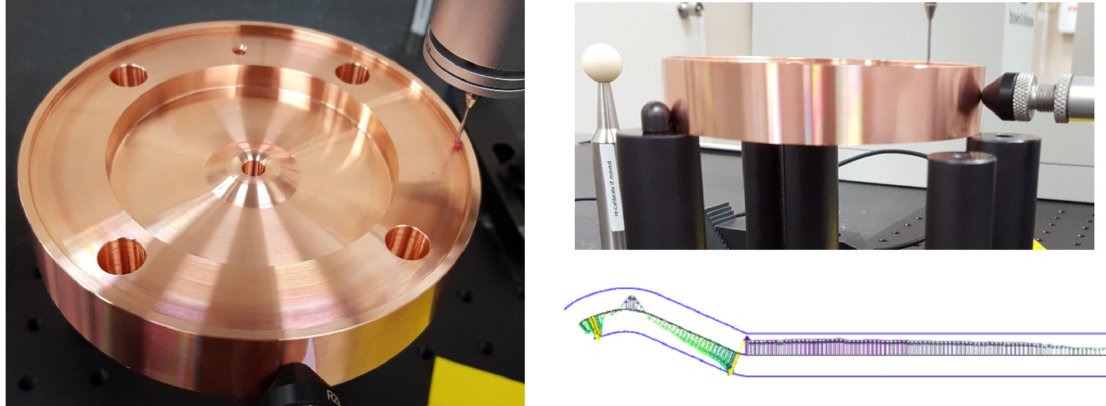
FIG. 23. Turned cell on CMM (left and top right), profile scan taken of the cell showing all dimensions within (cid:3) 10 microns tolerances.